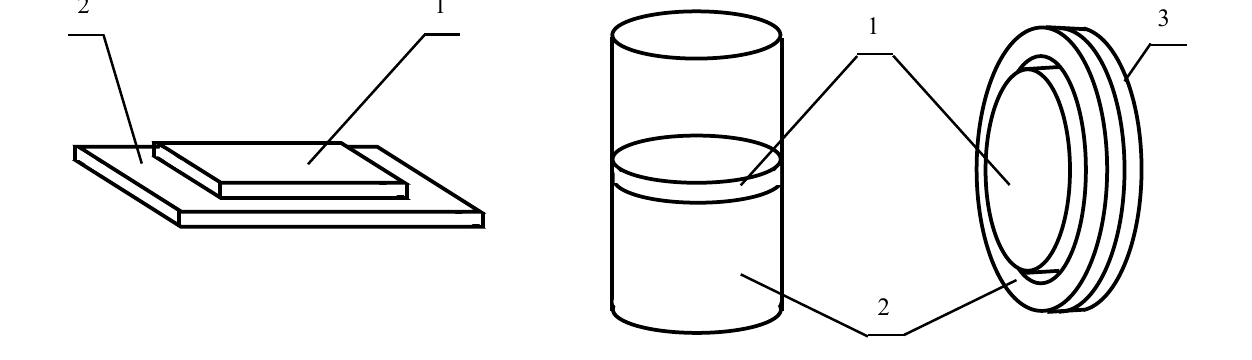
Fig. 1. Varieties of composite piezoceramic transformer